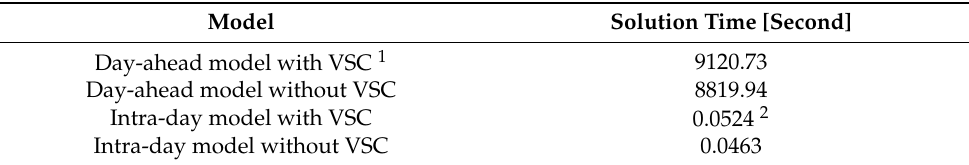
Table 1. Computational Time.